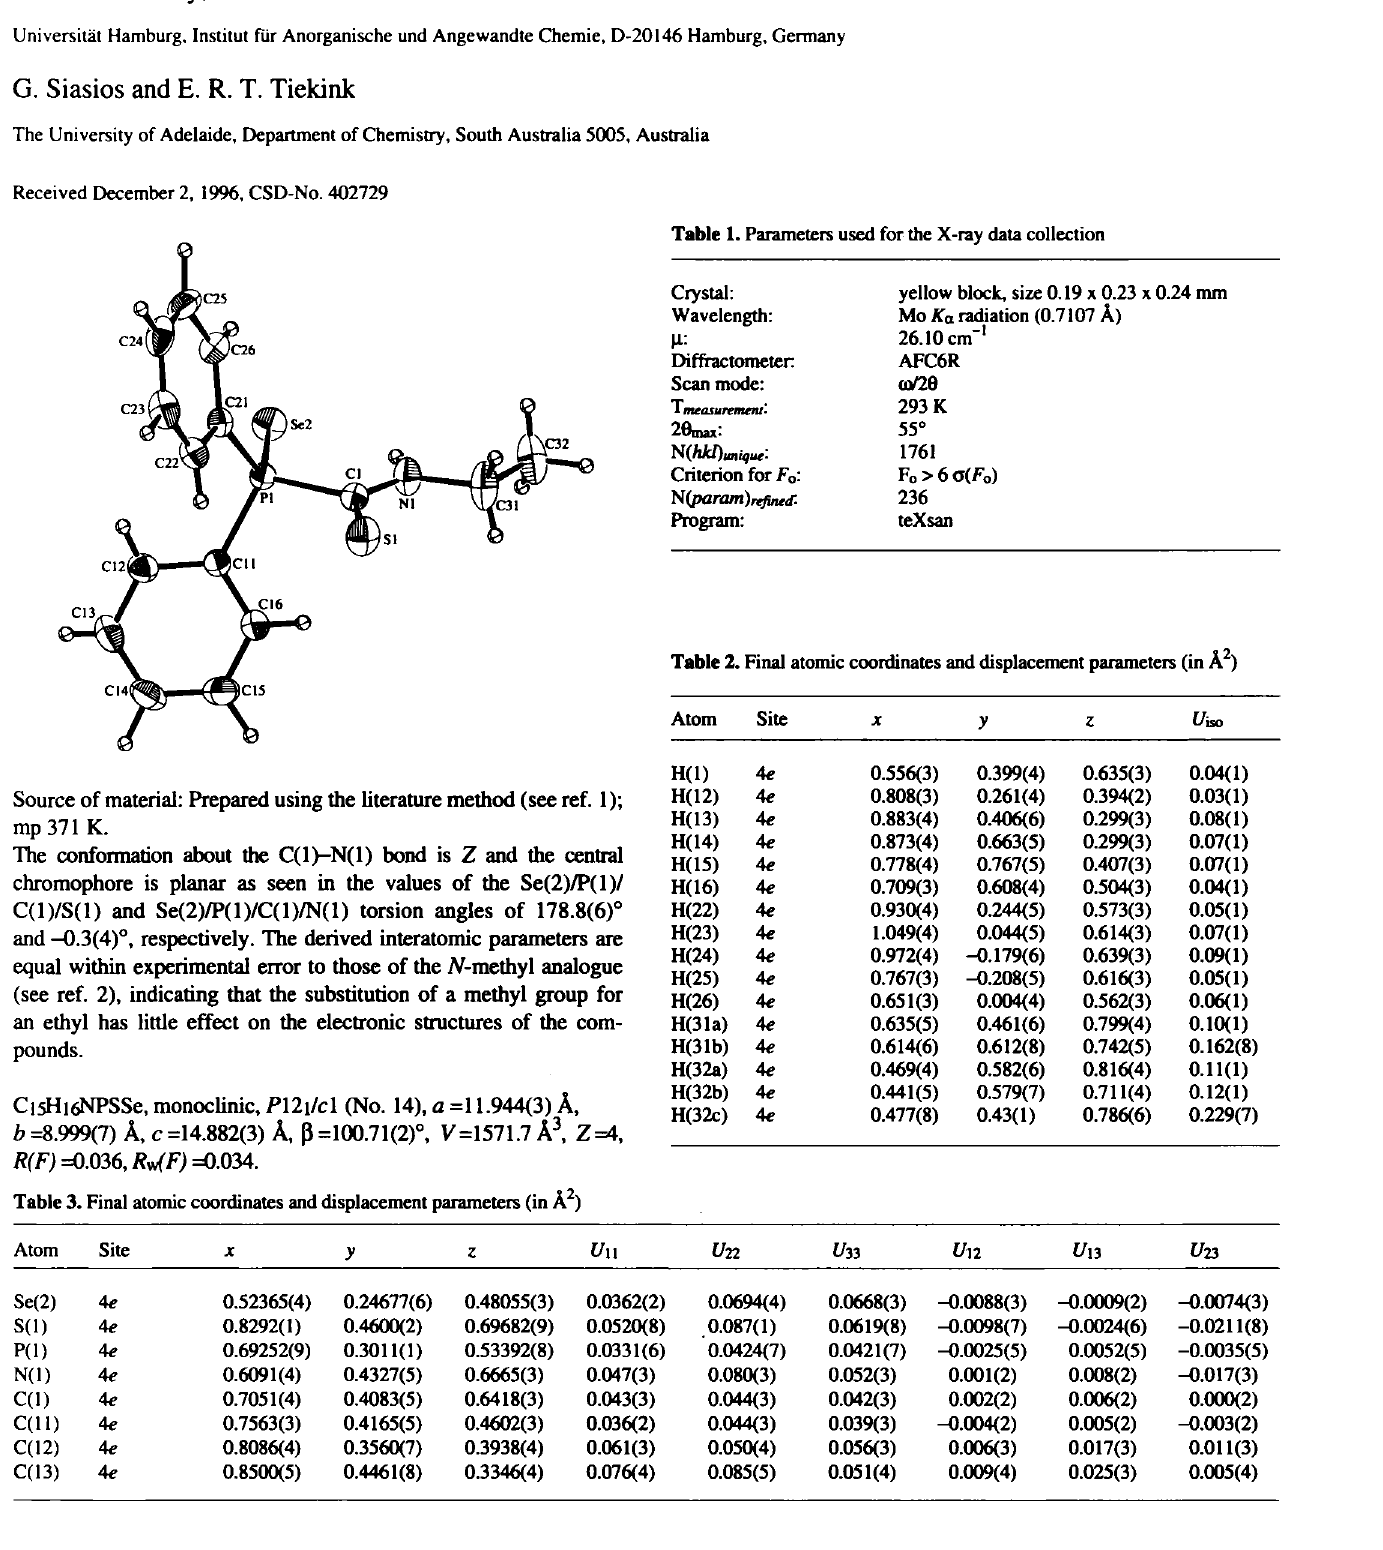
Table 1. Parameters used for the X-ray data collection